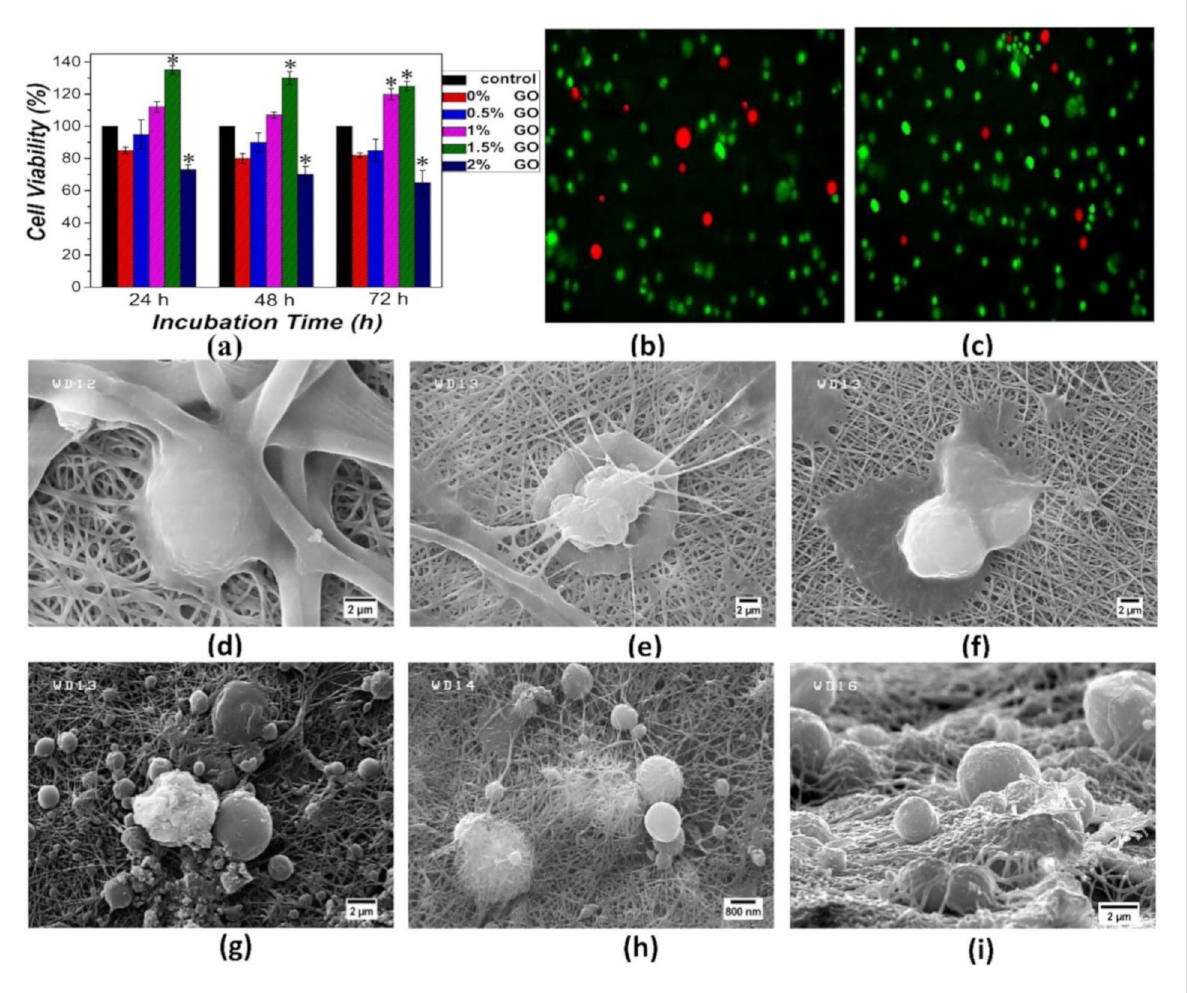
Figure 6: (a) The viability of mesenchymal stem cells in the developed electrospun membranes Live (green) and dead (red) staining of cells after 24 h of incubation. (b) Chitosan-based nanofibers without the addition of graphene oxide or (c) containing 1 wt % of graphene oxide. SEM images show the geometry of MSCs on the surface of membranes containing (d) 0% of graphene oxide, (e) 0.5% graphene oxide, (f) 1, (g) 1.5, and (h) 2% of graphene oxide. Figure 6 was reprinted from [72], Materials Science and Engineering: C, vol. 70, by N. Mahmoudi; A. Simchi, “On the biological performance of graphene oxide-modified chitosan/polyvinyl pyrrolidone nanocomposite membranes: In vitro and in vivo effects of graphene oxide”, pages 121–131, Copyright (2016), with permission from Elsevier. This content is not subject to CC BY 4.0.